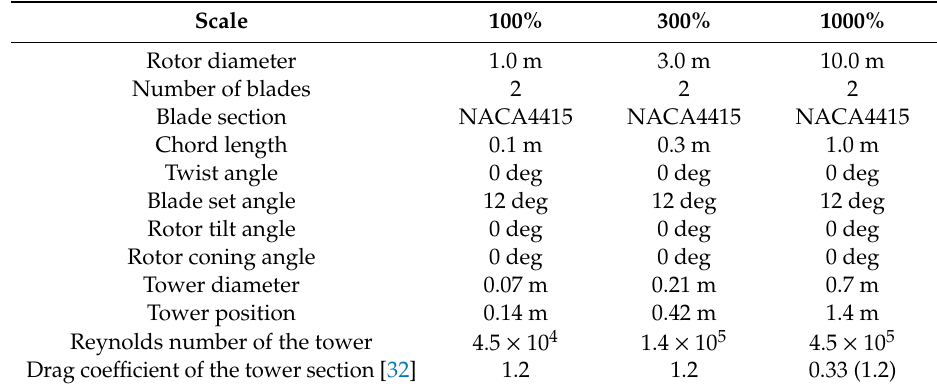
Table 4. Specifications of the analysis of scale e ff ects.